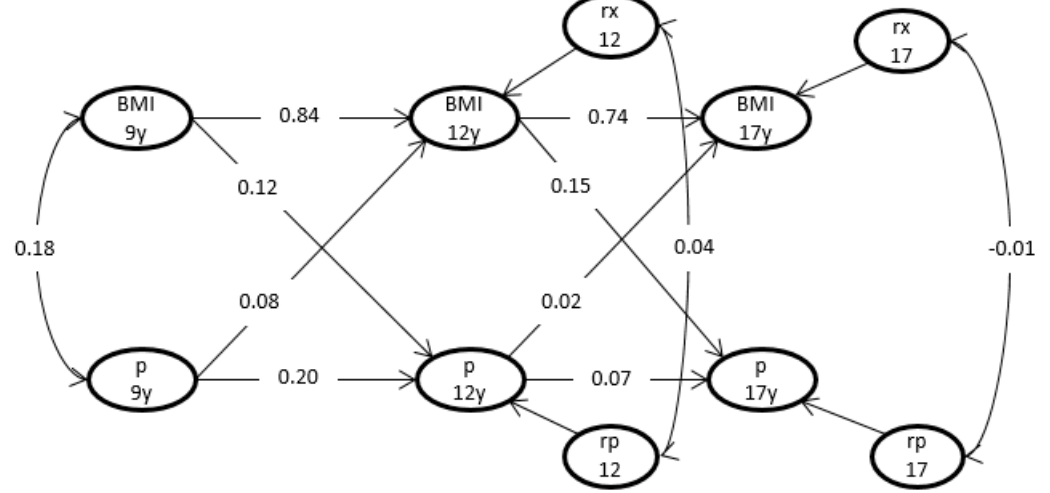
Figure 2. Estimates for parameters in a model for BMI and cortisol metabolite excretion rate. Cross-lagged correlation coefficients between BMI and cortisol metabolite excretion rate at ages 9, 12, and 17 year. BMI 9y = body mass index at 9 years of age. p 9y = cortisol metabolite excretion rate at 9 years of age. rx and rp are residuals for BMI and cortisol metabolite excretion rate at ages 12 and 17 years.